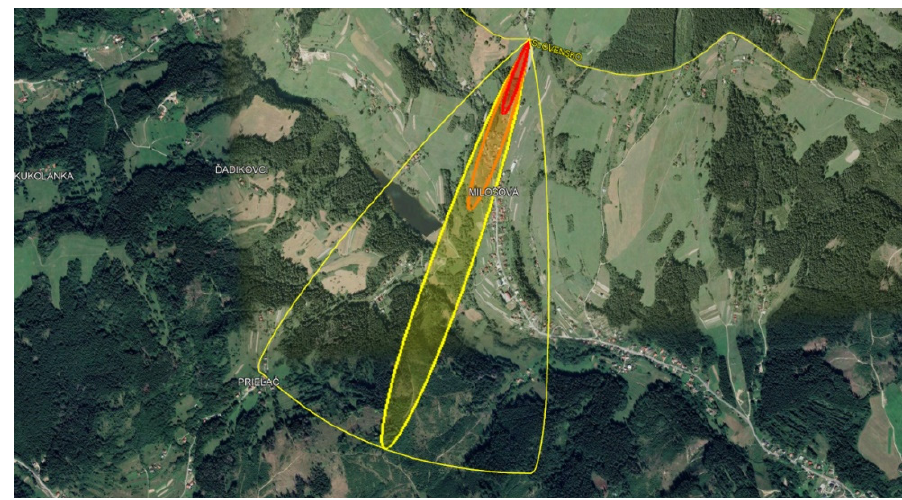
Figure 5. Graphical representation of the dispersion of a dangerous substance at the border crossing Č adca-Milošová-Šance [24,25].